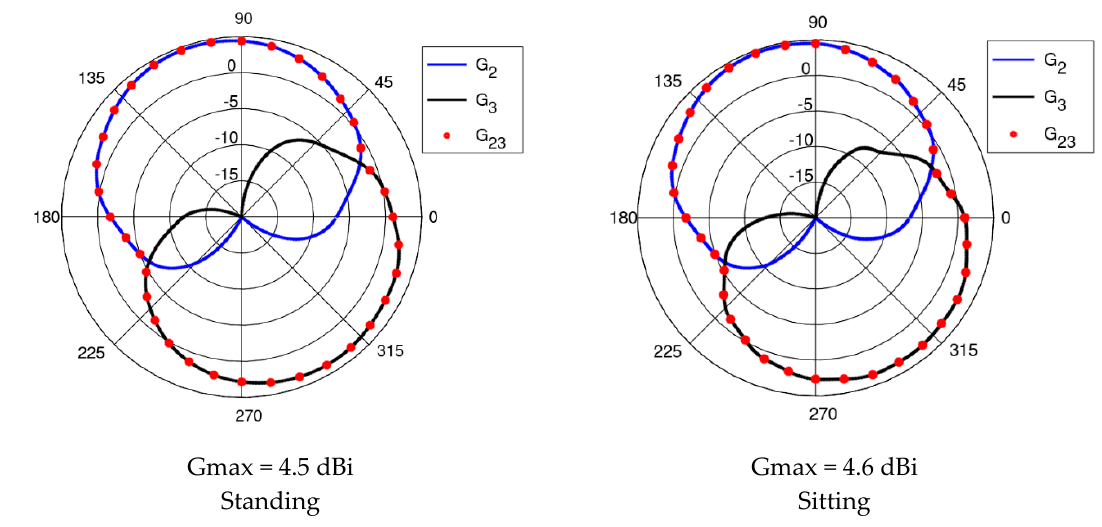
Figure 18. The radiation patterns for the final solution.